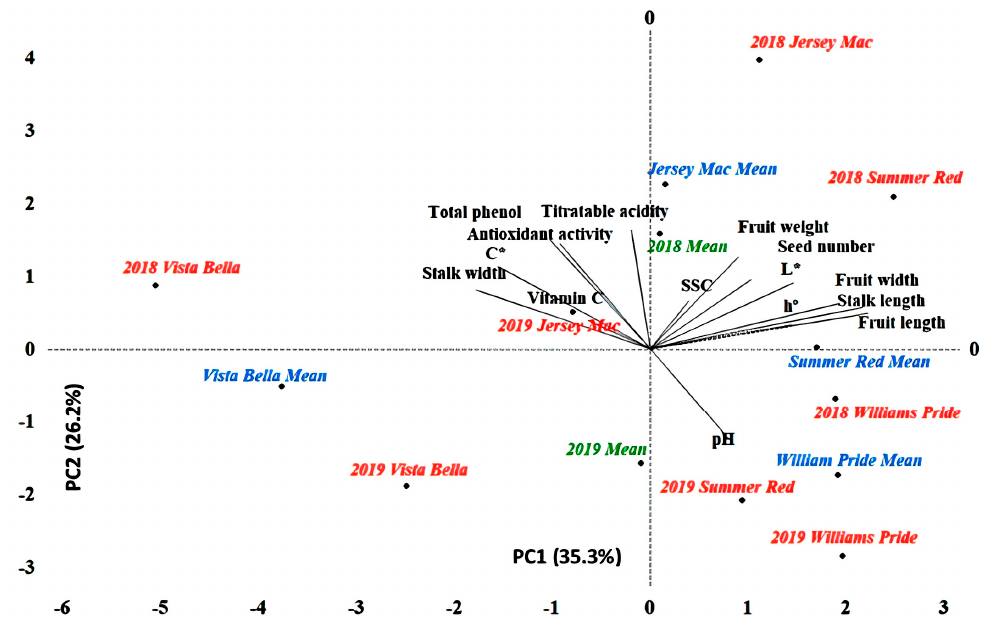
Figure 1. Bi-plot segregation of physico-chemical characteristics along with cultivars.